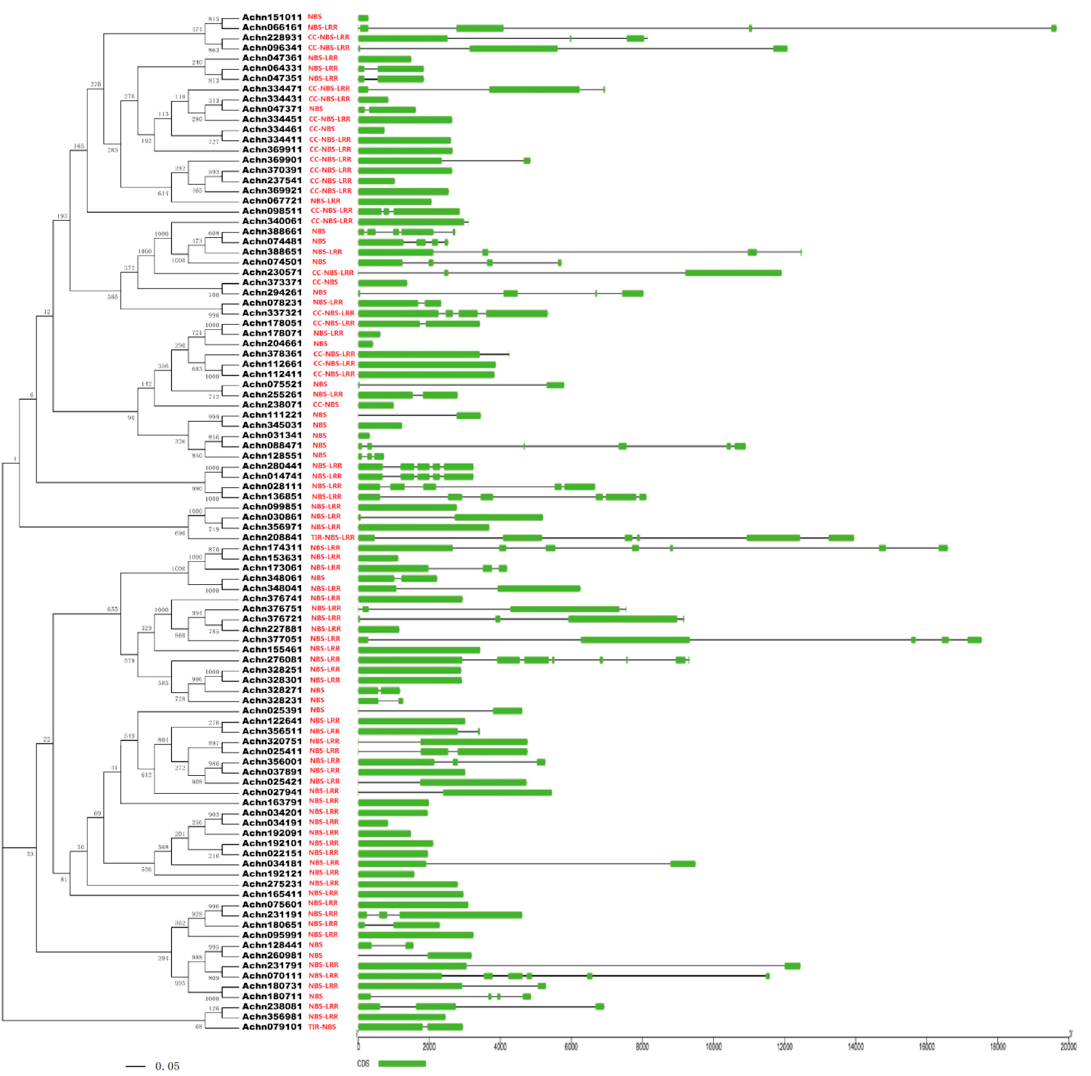
Figure 1. Phylogenetic tree and exon / intron structure of NBS-LRR genes of kiwifruit. The phylogenetic tree was generated using MAGA 5.0 with neighbor joining (NJ) method based on 1000 bootstrap replicates. The gene structure was retrieved from the General Feature File of kiwifruit genome. The phylogenetic tree was aligned with the gene structure along with the domain position using Gene Structure Display Serve.